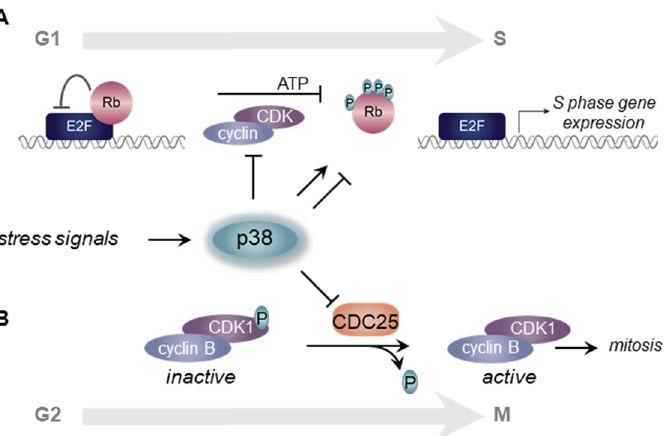
Figure 2. p38 regulates G1/S and G2/M cell cycle transitions. ( A ) The G1/S transition is controlled by Rb phosphorylation and CDK status. When activated by cellular stress, p38 α phosphorylation of RB maintains inhibition of E2F. p38 also mediates G1 arrest by phosphorylating cyclin D resulting in its degradation. Alternatively, p38 γ phosphorylates Rb similar to CDK releasing E2F inhibition. ( B ) The G2 transition into mitosis is controlled by cyclin B-activated CDK1. During G2, phospho-CDK1 is inactive, and the dephosphorylation of CDK1 by CDC25 activates CDK1/cyclin B. In response to